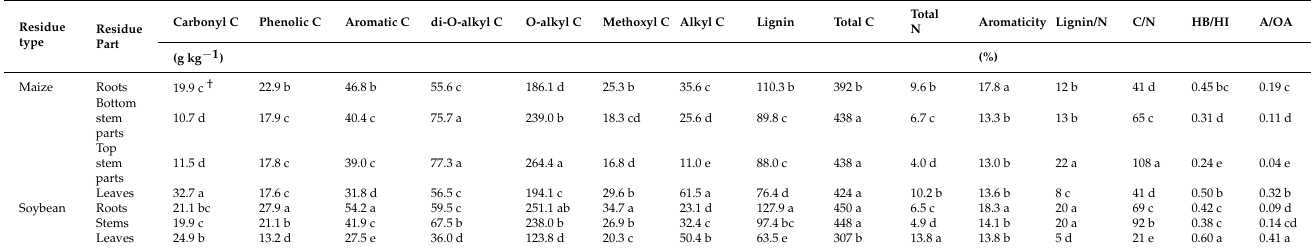
Table 2. Chemical characteristics of different parts of maize and soybean residues before